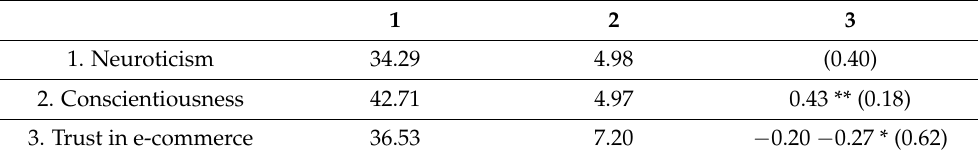
Table 2. Means, Standard Deviation and Bivariate Correlations between the Variables ( n = 89). 1 2 3